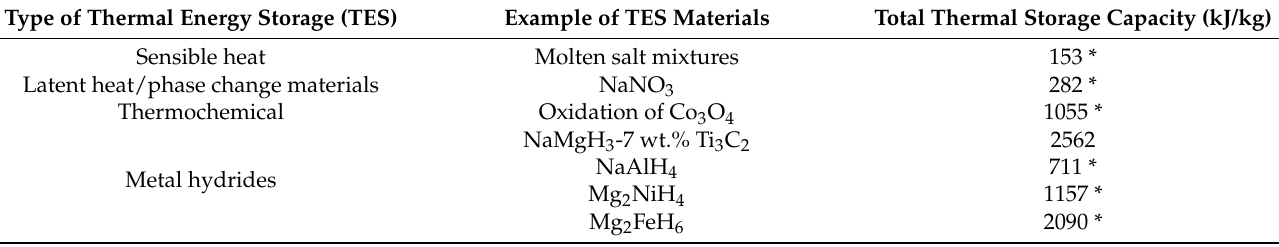
Table 2. Thermal energy storage densities of different thermochemical energy storage materials [41–44].